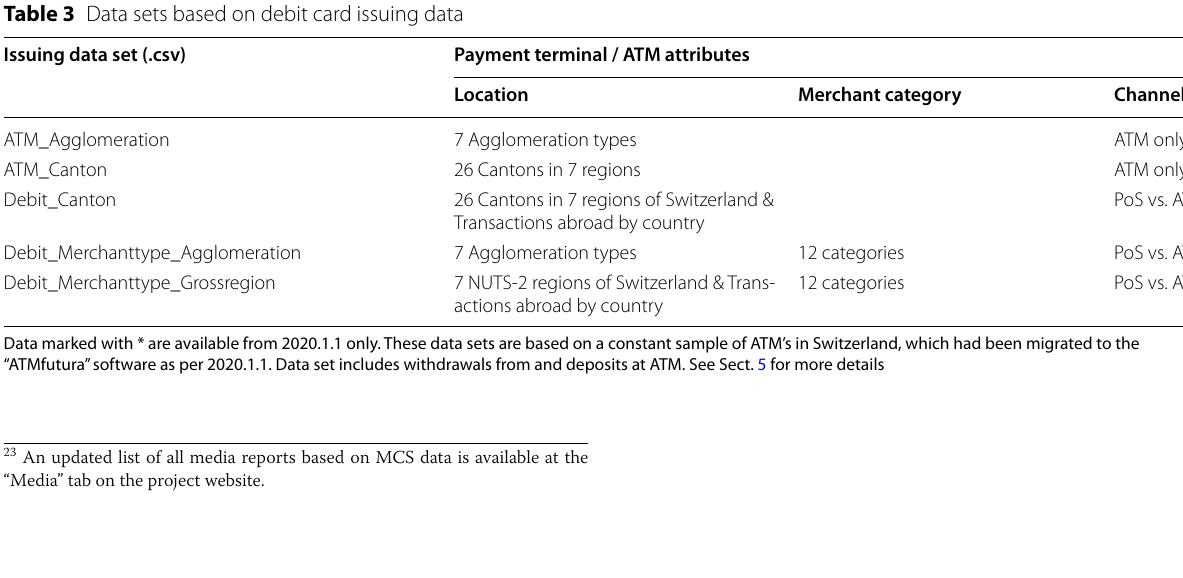
Table 3 Data sets based on debit card issuing data Issuing data set